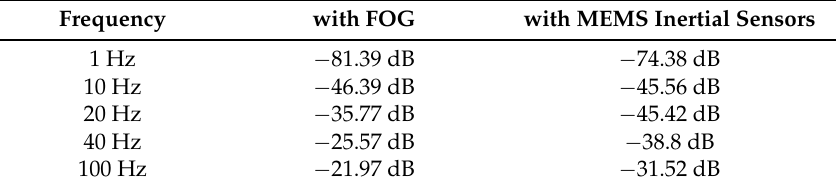
Table 2. Comparison between disturbance suppressions of two kinds of FSM control